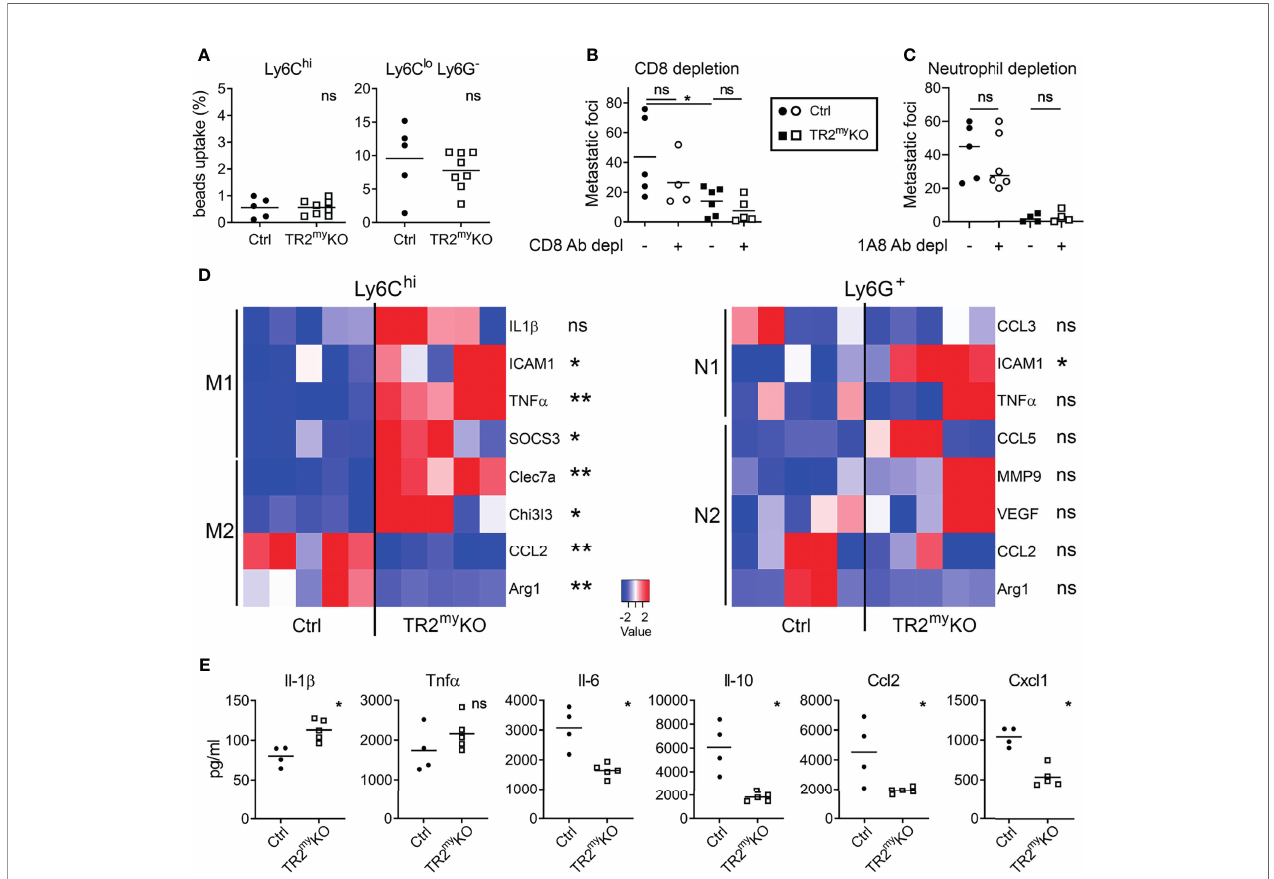
FIGURE 4 | Altered polarization of Tgfbr2 -de fi cient monocytic cells resulted in reduced liver metastasis. Characterization of myeloid cells from TR2 my KO and Ctrl mice at day 14 post-intrasplenic injection of MC-38GFP cells. (A) The phagocytic capacity of Ly6C hi monocytes and Ly6C lo /Ly6G - macrophages isolated from metastatic livers 9 hours after the intravenous injection of fl uorescent beads. (B) Liver metastasis of MC-38GFP cells upon anti-CD8 antibody or isotype control depletion in TR2 my KO and Ctrl mice. Mice were terminated at day 28 and liver metastasis quanti fi ed. (C) Liver metastasis of MC-38GFP cells upon anti-Ly6G (1A8) antibody or isotype control depletion in TR2 my KO and Ctrl mice. Mice were terminated at day 28, and liver metastasis quanti fi ed. (D) Gene expression analysis of Ly6C hi /tdT + monocytes and Ly6G + / tdT + neutrophils sorted from livers of tdT-reporter TR2 my KO and Ctrl mice at day 14 post-tumor cell injection performed by qPCR. A panel of genes associated with M1 and M2 macrophage polarization and N1 and N2 neutrophil polarization was analyzed. (E) Analysis of cytokine production by tdT + sorted Ly6C hi monocytes from livers of TR2 my KO and Ctrl mice 14 days post-intrasplenic injection of MC-38GFP cells. Cells were stimulated overnight and secreted cytokines were measured in supernatants. Statistical signi fi cance was assessed using Mann-Whitney test: ns, not signi fi cant; *p < 0.05; **p <